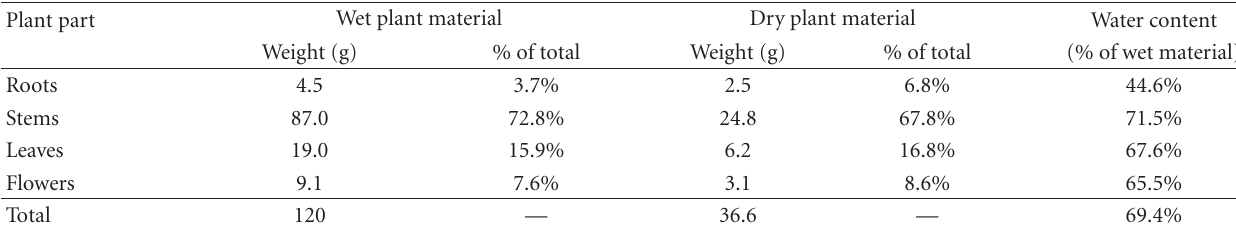
Table 1: Distribution of morphological components of white clover from a 17 × 17cm field